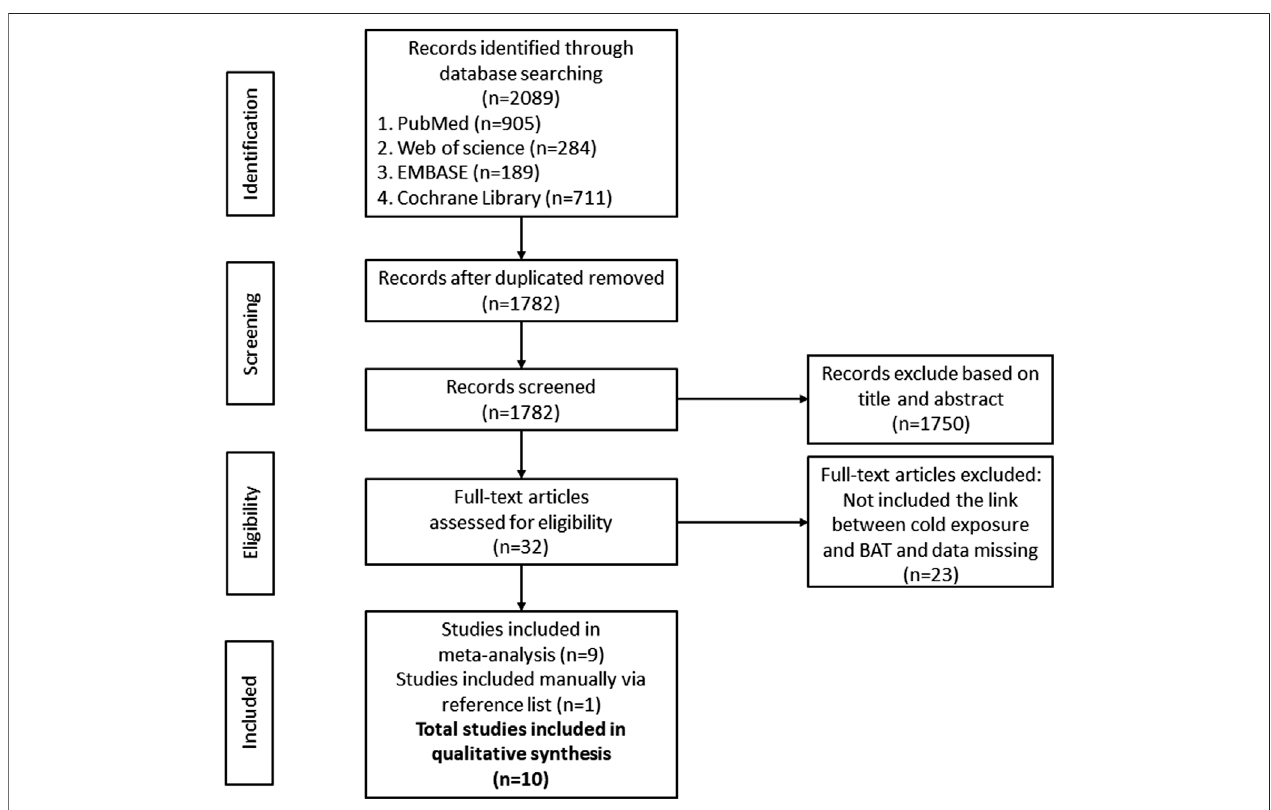
FIGURE 1 | Flow Diagram of studies included in the systematic review and